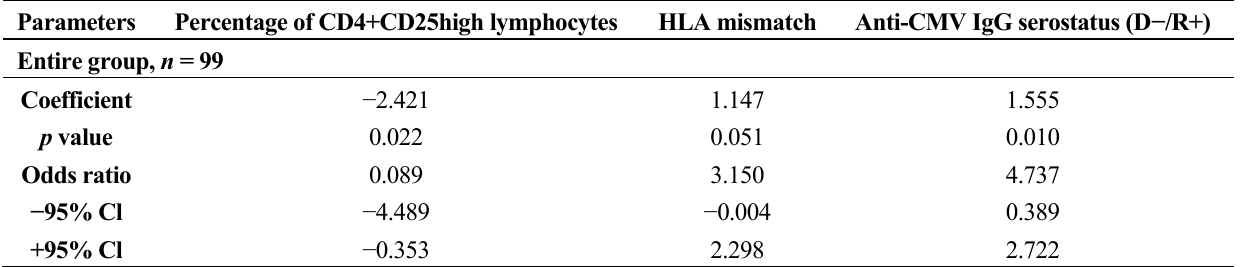
Table 2. Multivariate analysis of factors associated with herpes virus (CMV, EBV, and/or HHV6)